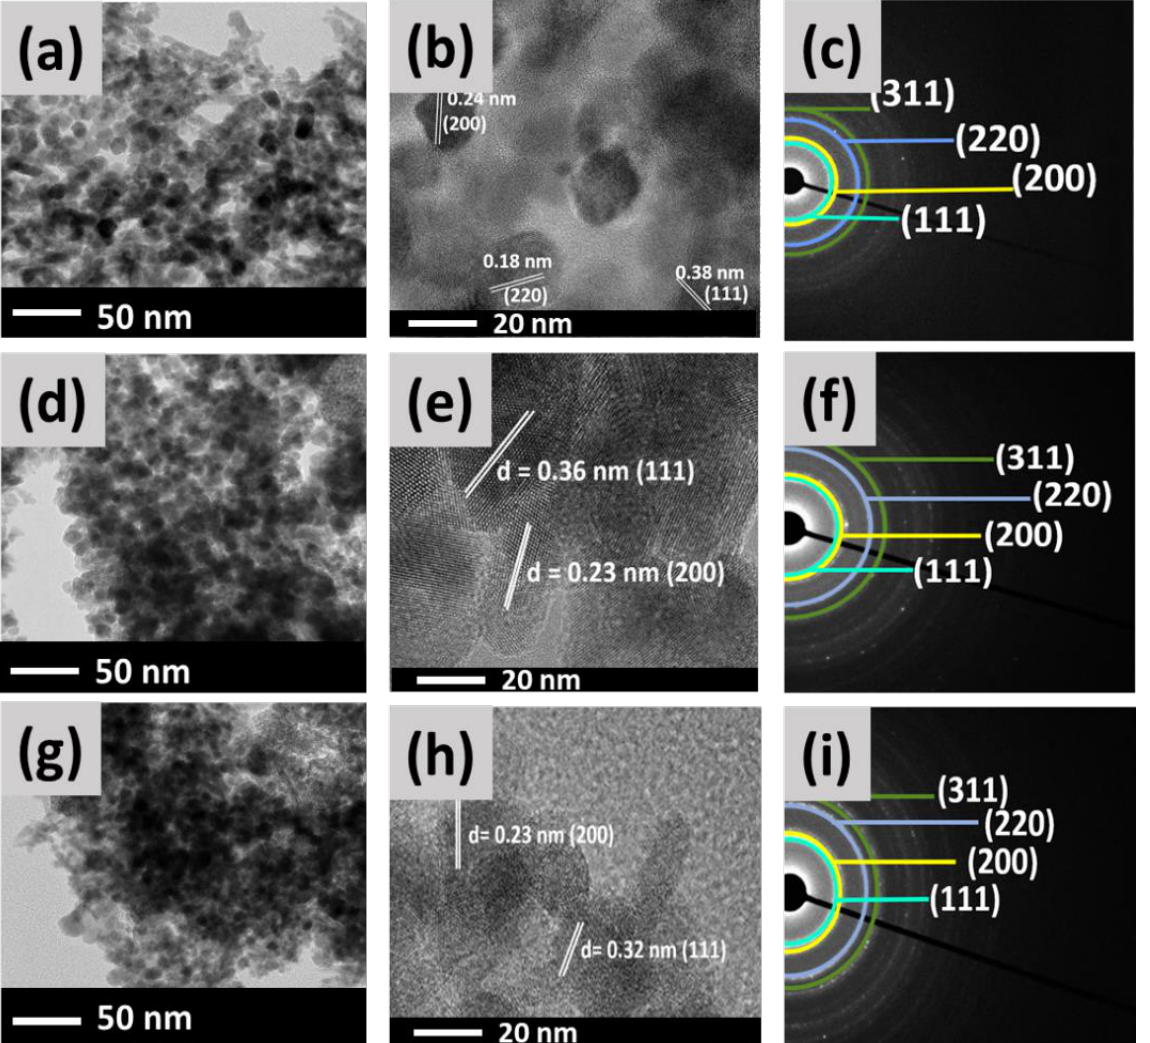
Figure 5. TEM, HR-TEM, and SAED patterns of ( a – c ) S − CeO 2 , ( d – f ) 0.5% Pd − CeO 2 , and ( g – i ) 5% Pd − CeO 2 NPs.